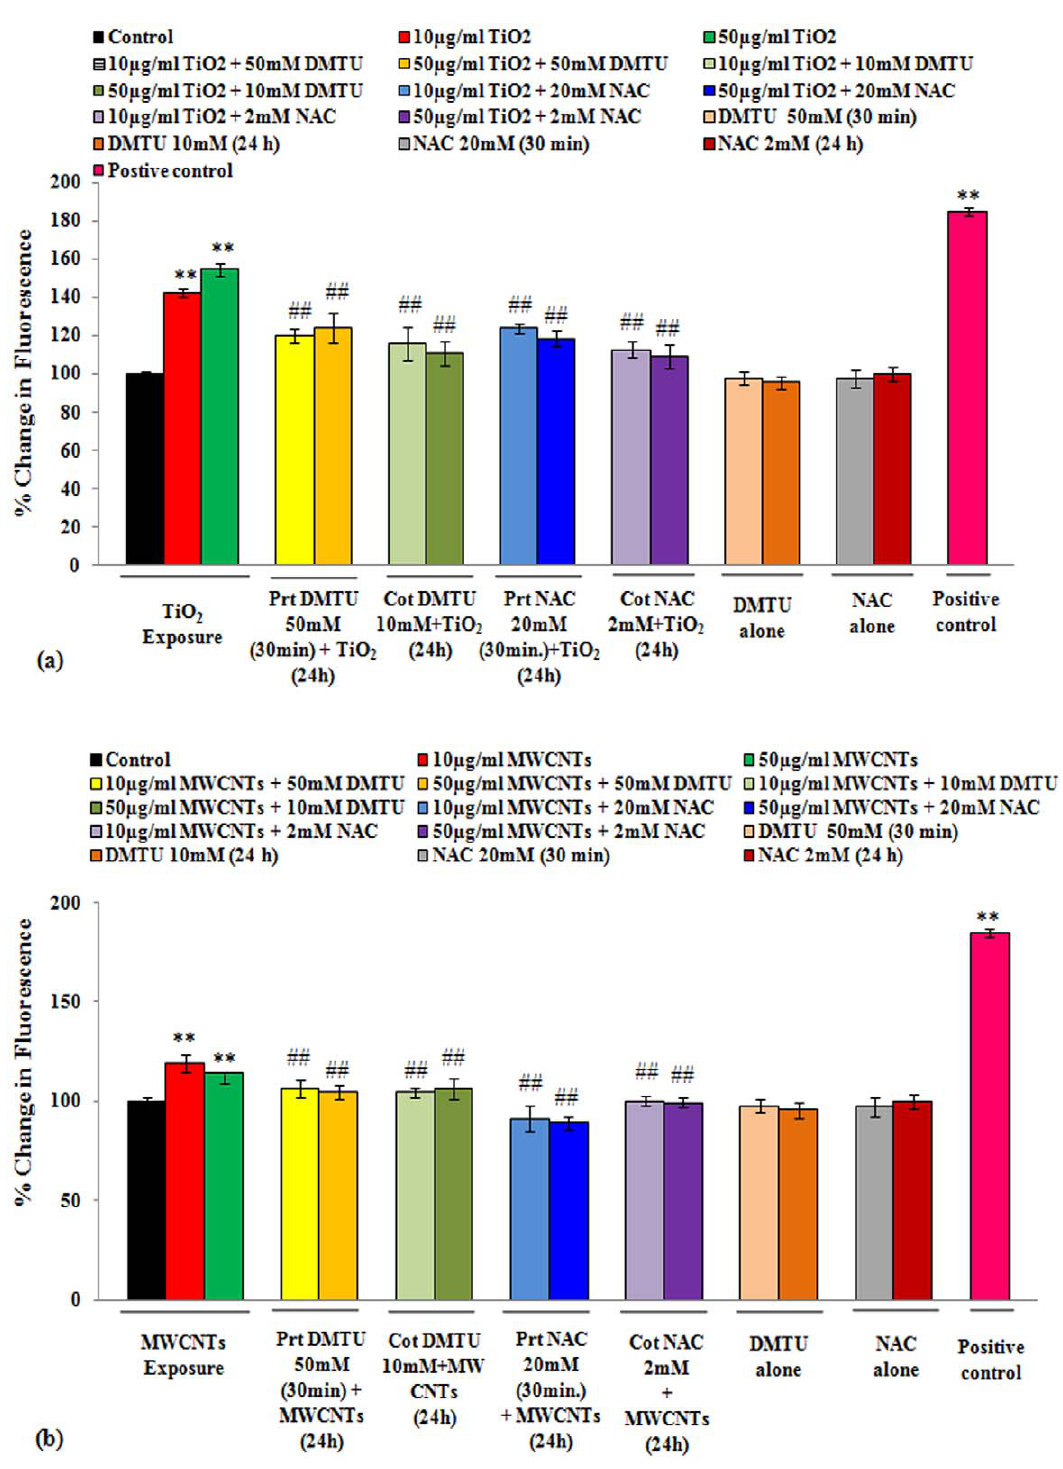
Figure 4. Effect of DMTU/NAC on the restoration of ROS generated in A549 cells exposed to TiO 2 -NPs/ MWCNTs. ROS generation was detected using ‘2, 7-dichlorofluorescin diacetate (DCFH-DA) dye. ( a ) In short term group, cells were pre-treated with either of DMTU or NAC for 30 minutes followed by exposure of TiO 2 -NPs (10 & 50 m g/ml) for 24 h. In long term group, cells were receiving a co-exposure (24 h) of DMTU/NAC and TiO 2 -NPs (10 & 50 m g/ml). Cells were then analyzed for DMTU/NAC mediated restoration in the levels of intracellular ROS, which was induced by the exposure of TiO 2 -NPs. All values are mean 6 S.E. of 3 experiments. ** P , 0.01(unexposed control Vs TiO 2 -NPsexposure). ## P , 0.01 (TiO 2 -NPsexposure Vs DMTU/NAC treatment). The positive control group was consisting of A549 cells pre-treated (1h) with 500 m M of H 2 O 2 . ( b ) In short term group, cells were pre-treated with either of DMTU or NAC for 30 minutes followed by exposure of MWCNTs (10 & 50 m g/ml) for 24 h. In long term group, cells were receiving a co-exposure (24 h) of DMTU/NAC and MWCNTs (10 & 50 m g/ml). Cells were then analyzed for DMTU/NAC mediated restoration in the levels of intracellular ROS, which was induced by the exposure of MWCNTs. All values are mean 6 S.E. of 3 experiments. ** P , 0.01 (unexposed control Vs MWCNTs exposure). ## P , 0.01 (MWCNTs exposure Vs DMTU/NAC treatment). The positive control group was consisting of A549 cells pre-treated (1h) with 500 m M of H 2 O 2 .